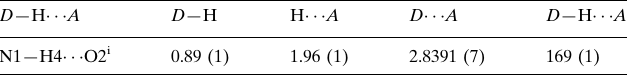
Hydrogen-bond geometry (A˚ , (cid:2)